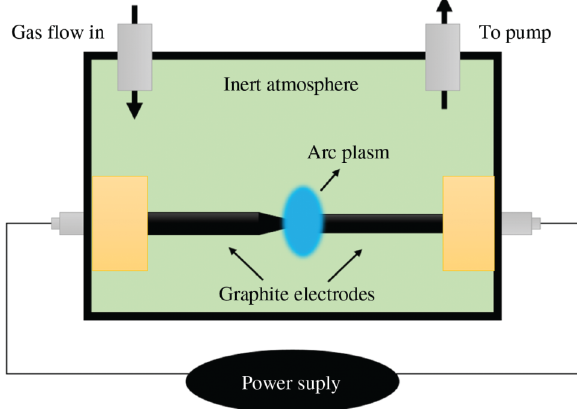
Figure 7: Schematic representation of the fullerene production by electric arc discharge